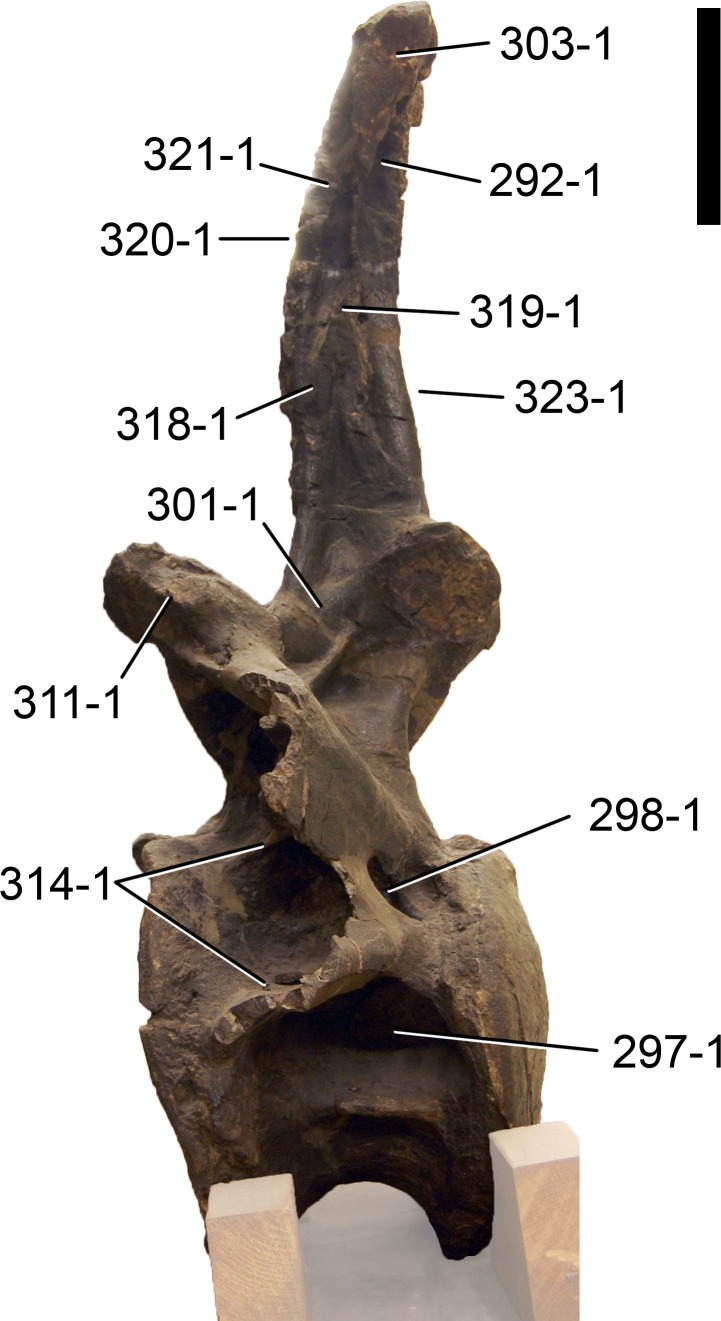
Anterior caudal vertebra of Diplodocus carnegii CM 94 in left lateral view.Note various characters typical for the genus: a depression between the lateral spinal lamina and the postspinal lamina (C292-1), the large pleurocoel (C297-1), an additional pneumatic foramen posterodorsally in the caudal centrum (C298-1), the accessory lamina between pre- and postzygapophysis (C301-1), a dorsally widened lateral spinal lamina (C303-1), a pre-epipophysis (C311-1), the double anterior centrodiapophyseal lamina (C314-1), the distinct spinoprezygapophyseal lamina that extends onto the lateral surface of the spine (C318-1) and contacts the spinopostzygapophyseal lamina (C319-1), the presence of a prespinal lamina (C320-1) with a thickened anterior rim (C321-1), and the presence of a postspinal lamina (C323-1). Scale bar = 10 cm.